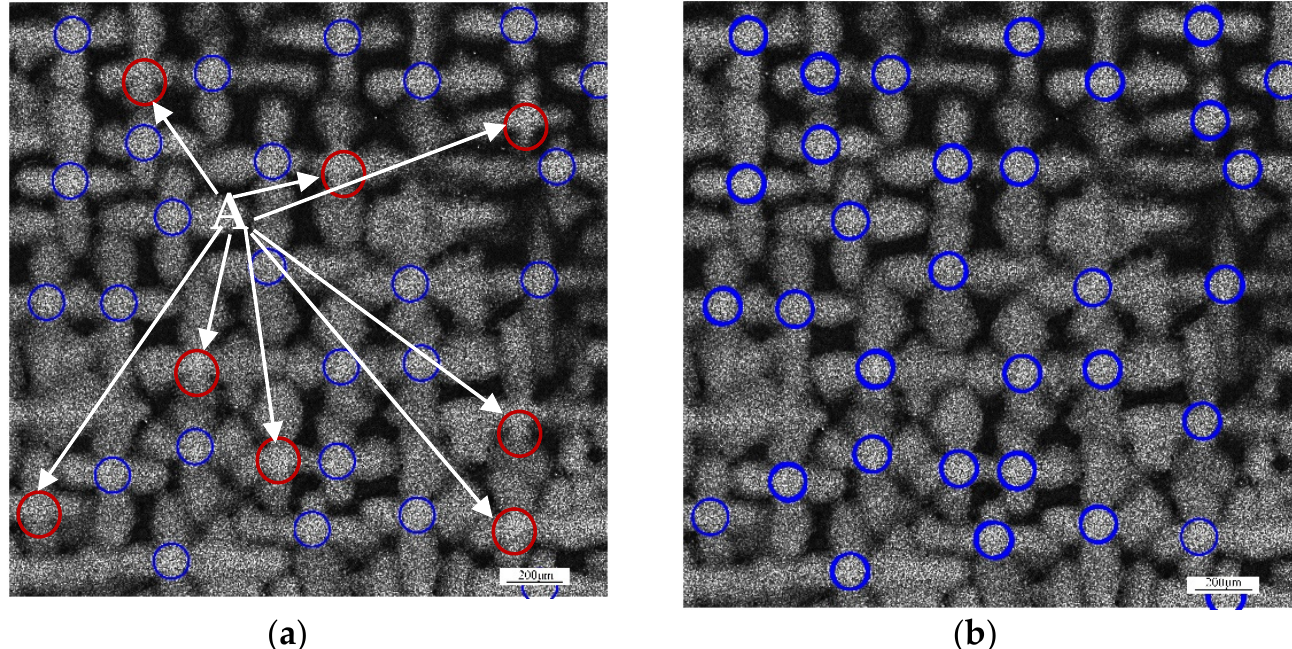
Figure 7. The recognition results of Faster R-CNN and TTA Faster R-CNN. ( a ) The extraction result of Faster R-CNN, A is the dendrite cores that were missed; ( b ) the extraction result of TTA Faster R- CNN.